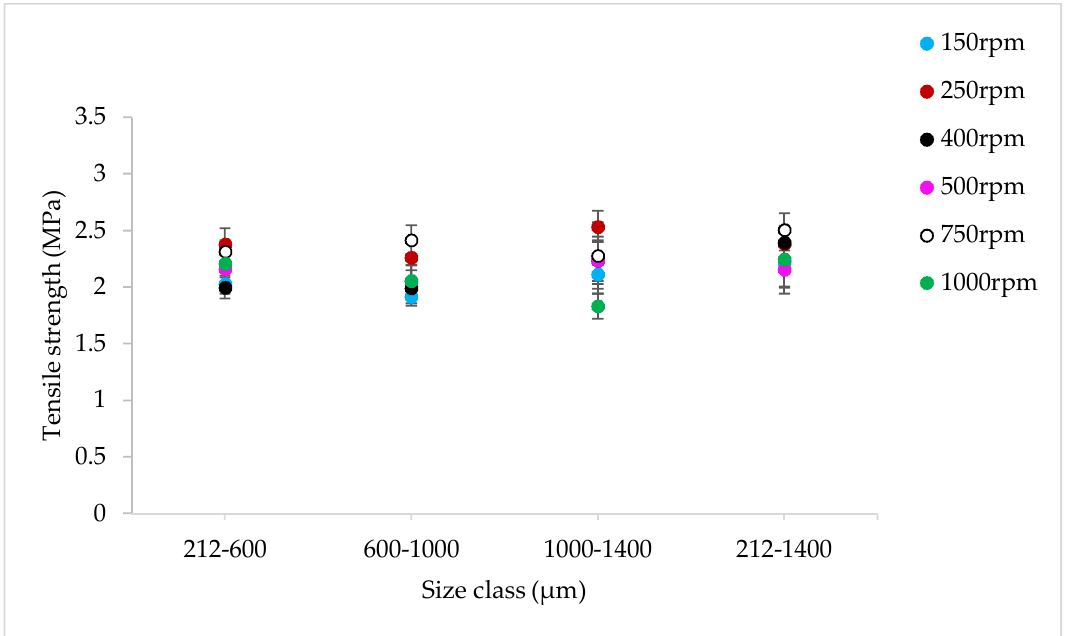
Figure 22. Tensile strength of tablets of MCC granules produced at varying screw speed at SFL—0.083 and PFN—6.74185 × 10 −5 (L/S 1).